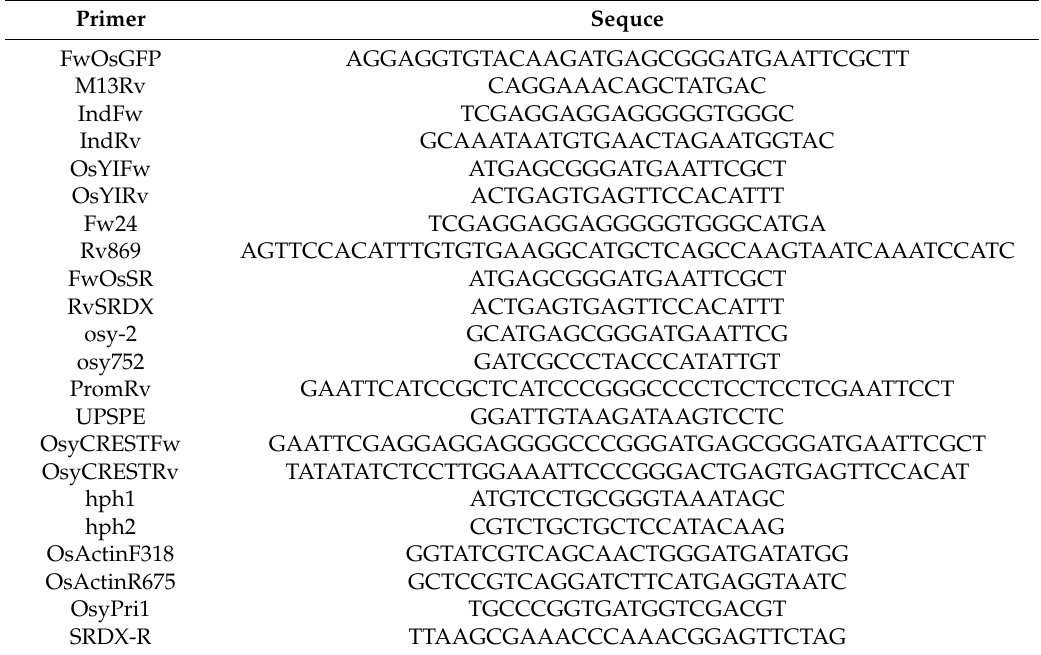
Table 1. List and sequence of